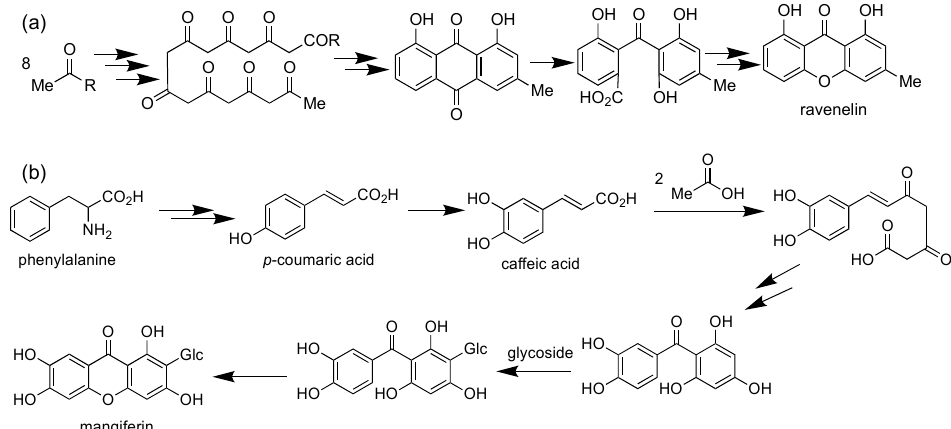
Figure 4. Brief biosynthesis pathway of xanthone derivatives through ( a ) acetate polymalonic path- way (biosynthesis of ravenelin), and ( b ) mixed shikimic acetate pathway (biosynthesis of man- giferin).